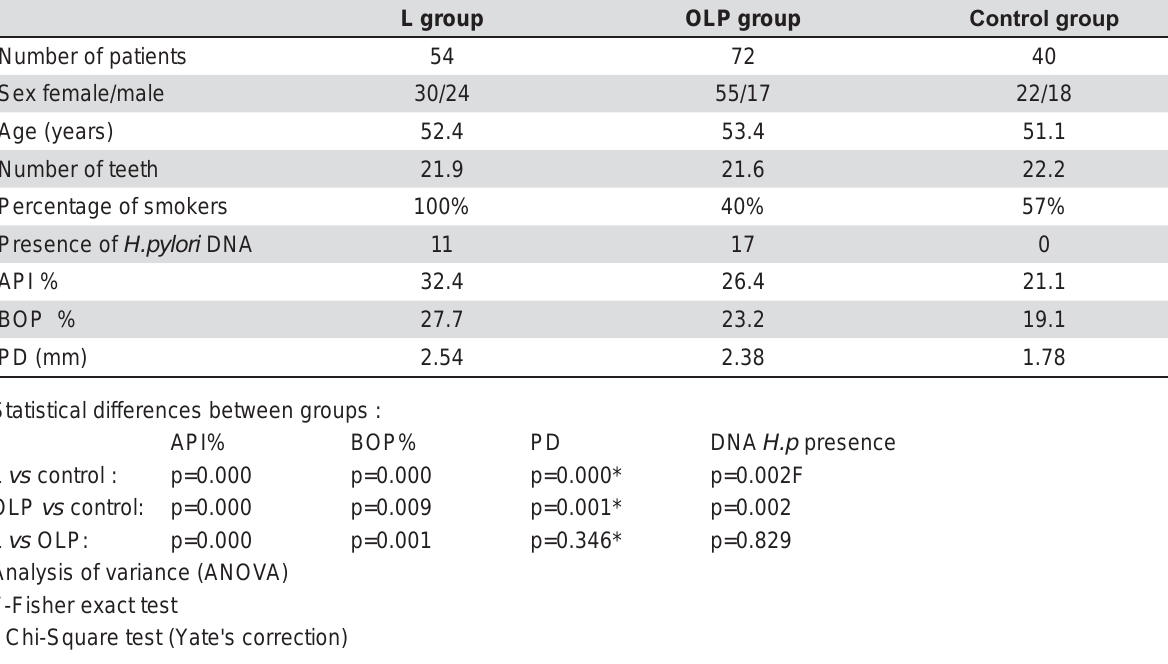
Table 1- Characteristics of patients